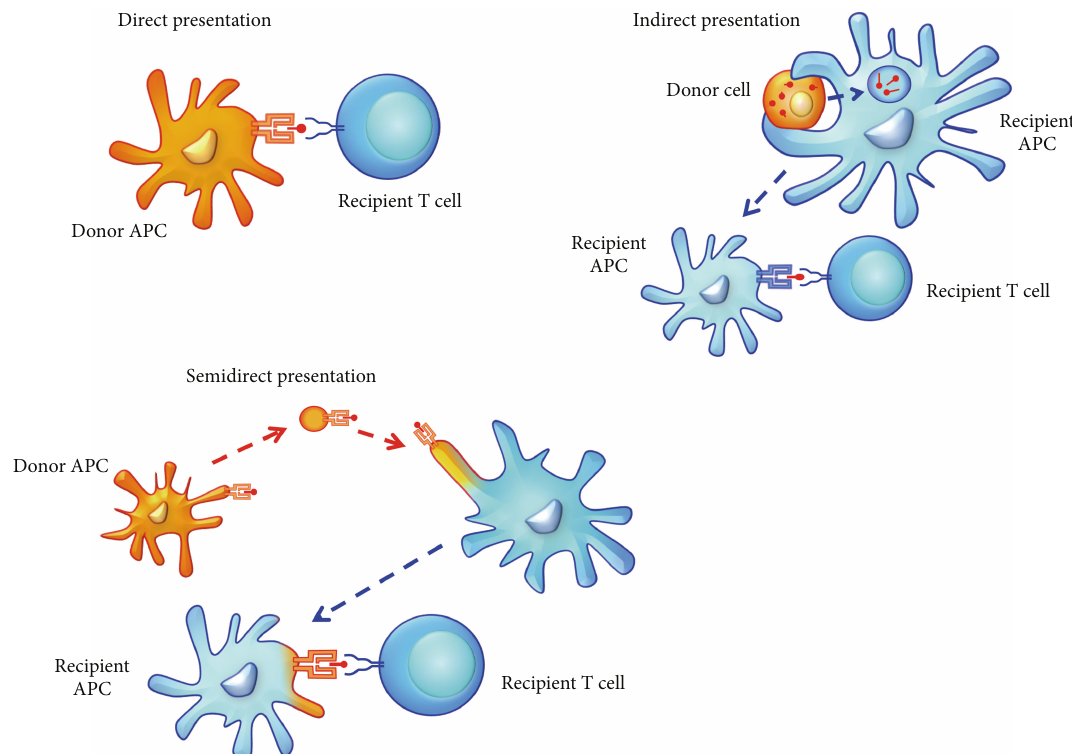
Figure 1: Mechanisms of alloantigen recognition. In direct presentation, donor APCs are able to present alloantigens to alloreactive T cells from the recipient. In indirect presentation, alloantigens are taken up from donor cells by recipient DCs that process and present alloantigens to alloreactive T cells. In semidirect presentation, intact MHC molecules are transferred to recipient DCs that directly present alloantigens through donor-MHC or process and present alloantigens as described for indirect